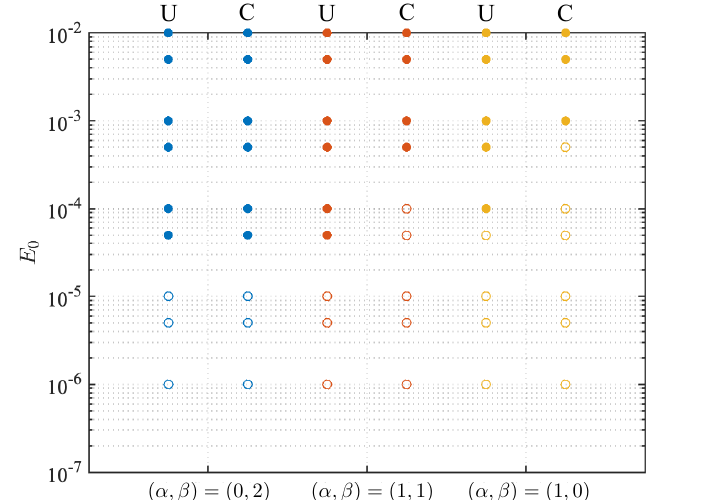
Figure 20. Summary of cases considered in the present work: Solid circle represents that laminar-to- turbulent transition occurs; open circle denotes that the flow remains laminar. U and C denote uncontrolled and controlled cases,